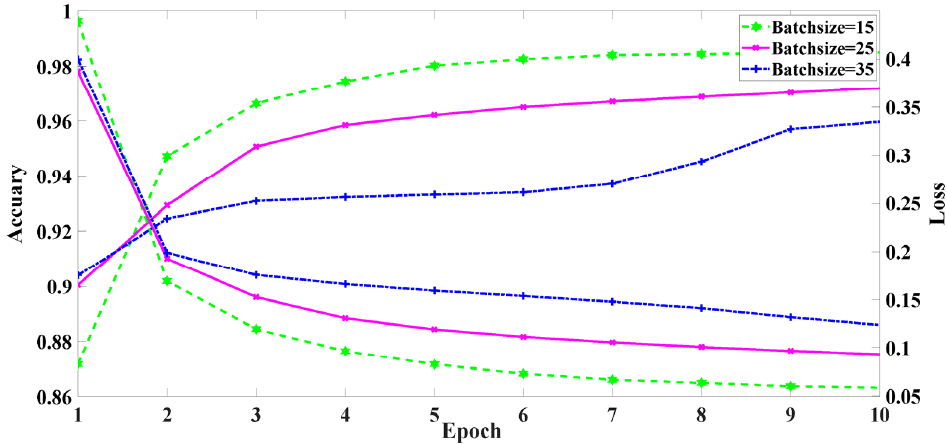
Figure 7. The model performance of different batch size.